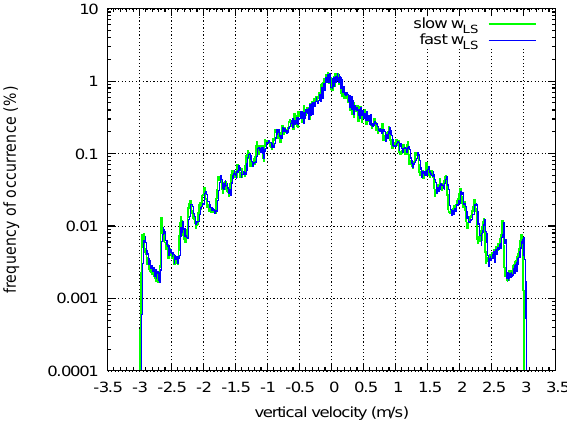
Fig. 10. Frequencies of occurrence of ice crystal number con- centrations from simulations in very slow large-scale motions ( w LS ≤ 1cms − 1 ) with homogeneous freezing (hom, green), het- erogeneous+homogeneous freezing (het+hom, blue) and a mixture of both (all, black); the red line represents the measurements of Krämer et al. (2009). Note that the lowest concentration bins of the model simulations are clipped for better comparison with the